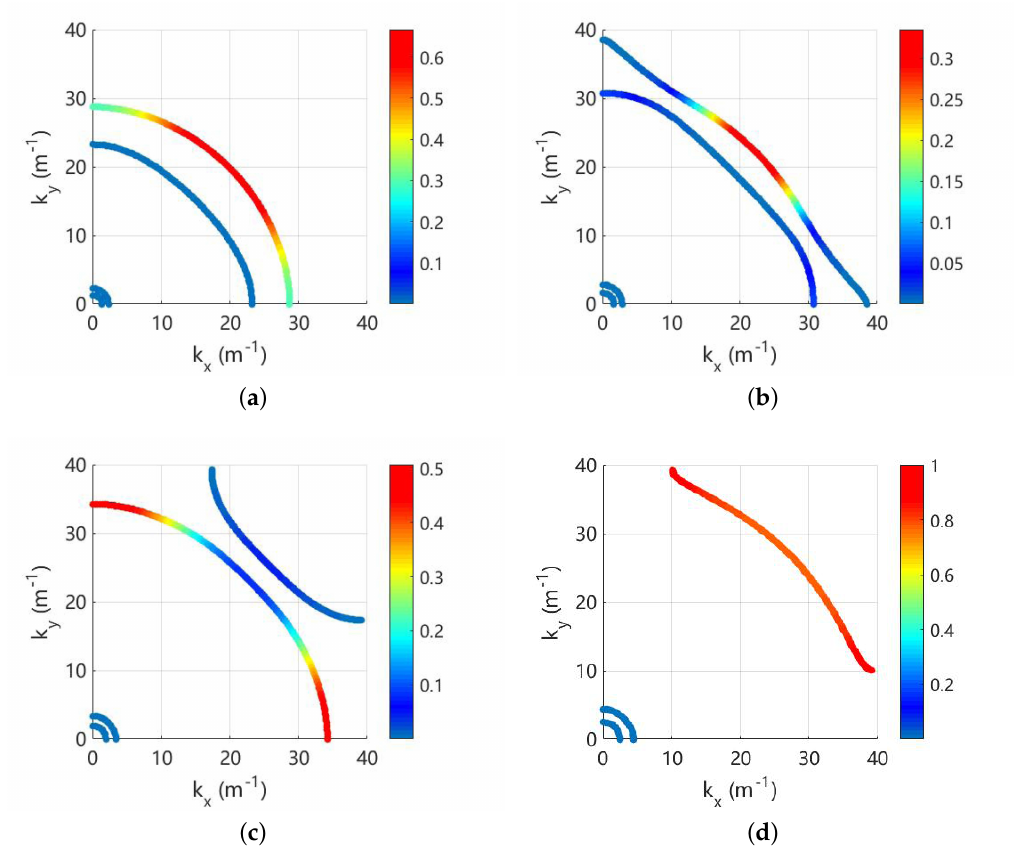
Figure 15. Wavenumber of the propagation waves for L-network with L = 0.5 H, coloured by RSW f : ( a ) at 440 Hz; ( b ) at 540 Hz; ( c ) at 640 Hz; ( d ) at 840